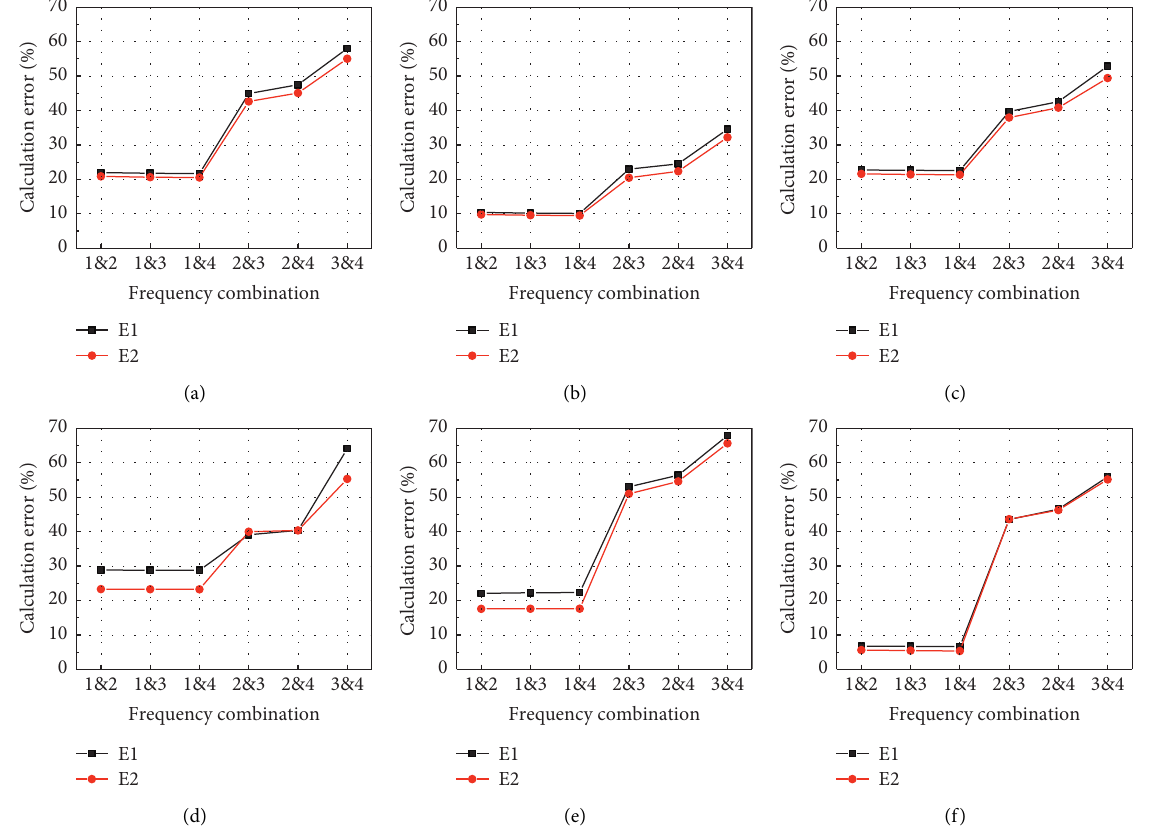
Figure 6: Calculation error of isolation displacement by using RD (PGA � 0.2g): (a) case 221, (b) case 222, (c) case 223, (d) case 224, (e) case 225, and (f) case 226.